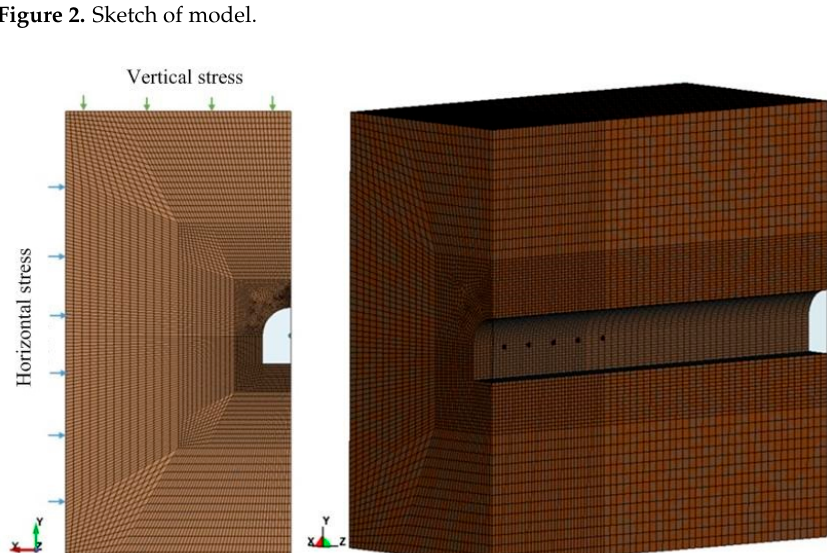
Figure 3. Grid division in finite element model.